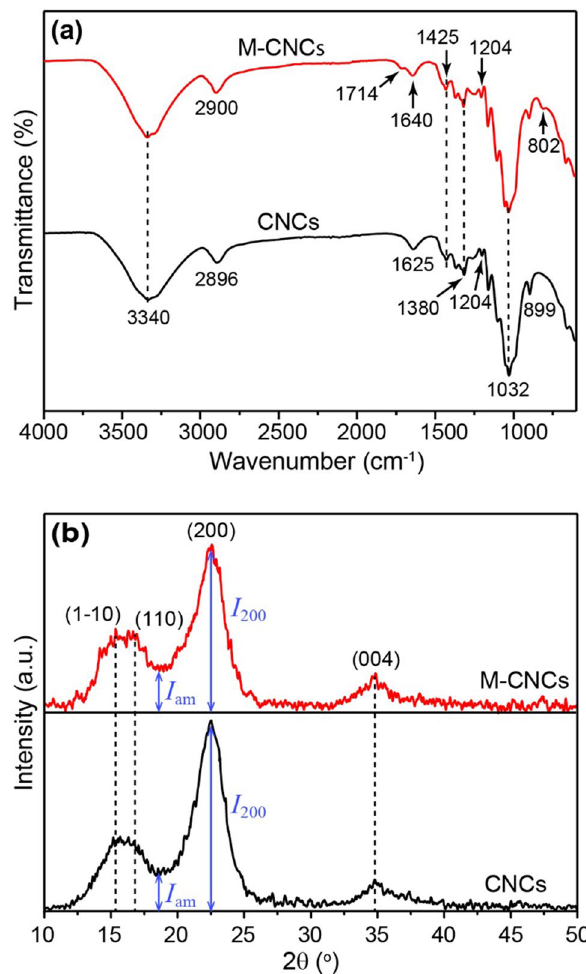
Figure 3. ( a ) FTIR spectra and ( b ) XRD patterns of CNCs and